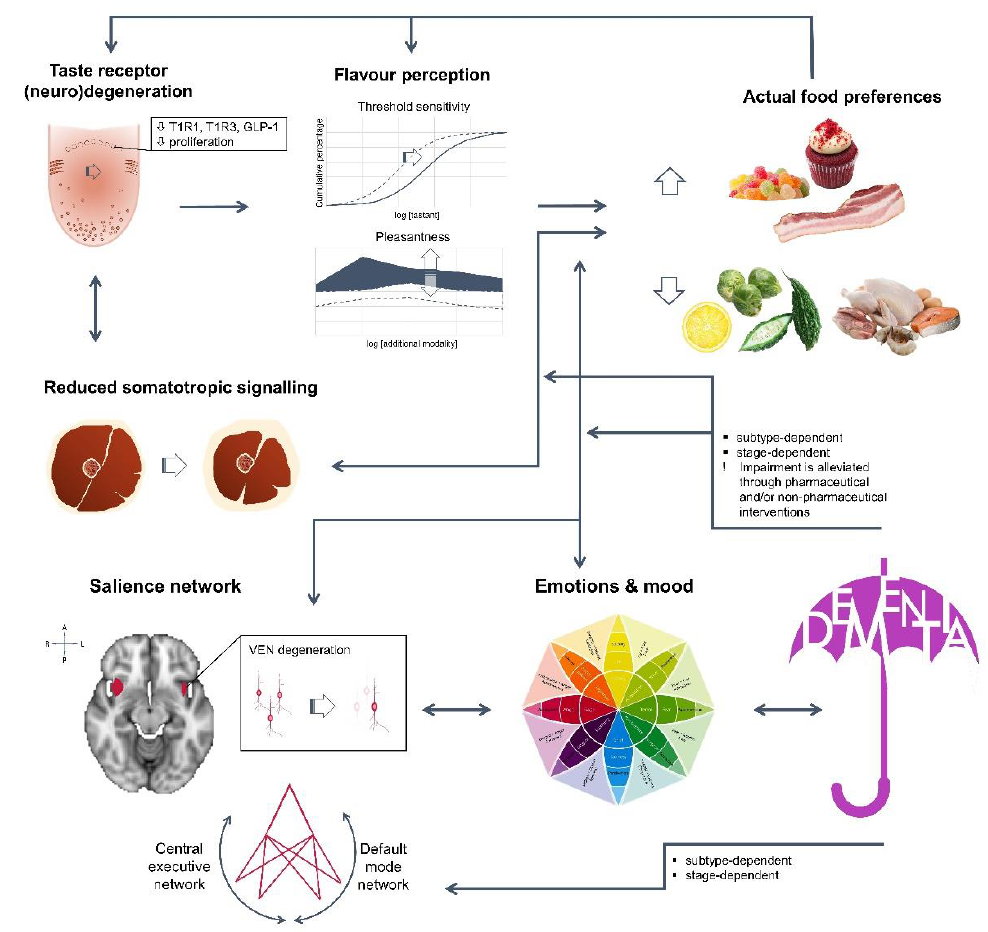
Figure 1. In dementia patients, weight and appetite impairment are due to multiple and reciprocal interconnections among body systems, with cognitive decline adding to the constitutive ageing process, rendering subjects vulnerable to malnutrition and frailty. T1R1: G protein-coupled Taste Receptor type 1 member 1; T1R3: G protein-coupled Taste Receptor type 1 member 3; GLP-1: Glucagon-Like Peptide-1; VEN: Von Economo neurons.